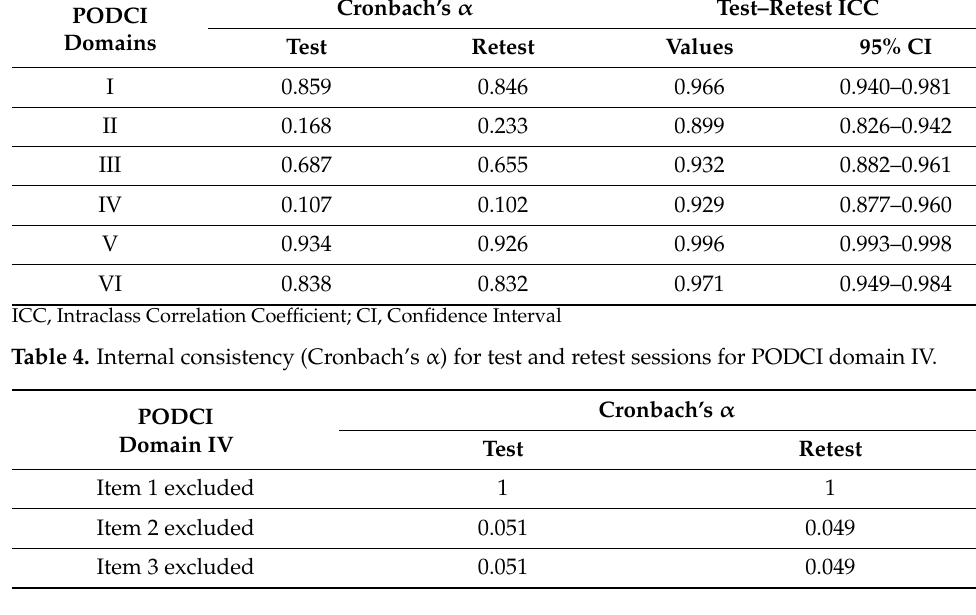
Table 5. Intercorrelations between Serbian version of PODCI scores.